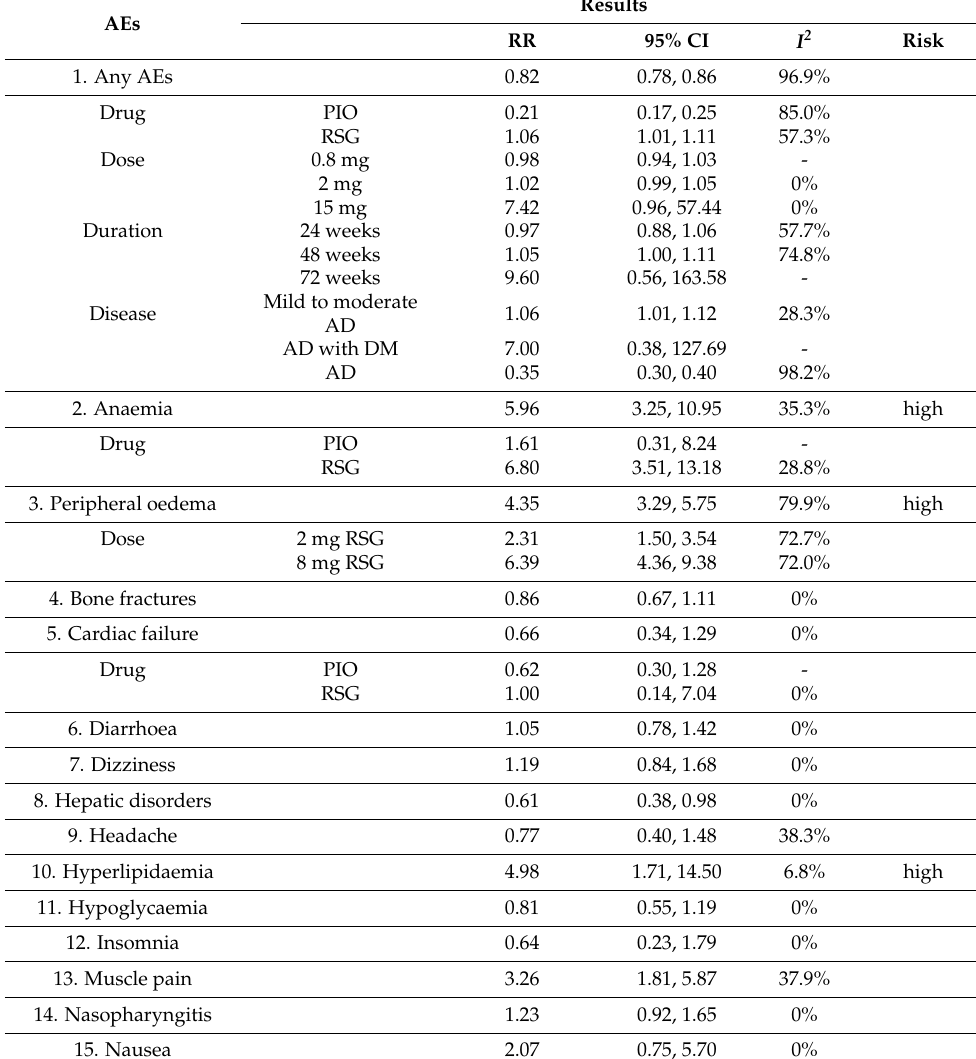
Table 4. Adverse events during PPAR- γ agonist